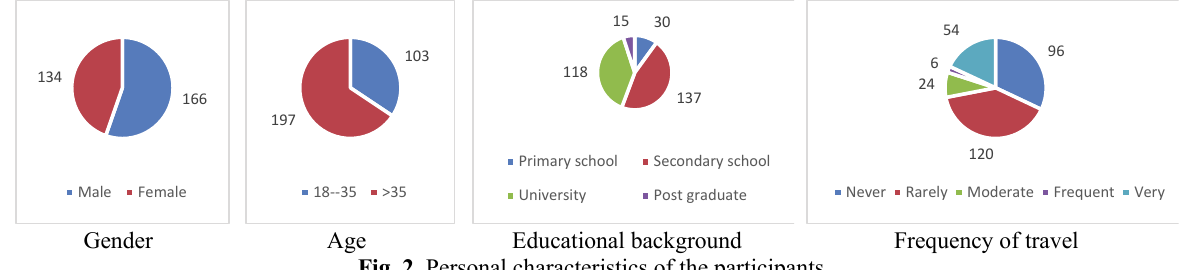
Fig. 2. Personal characteristics of the